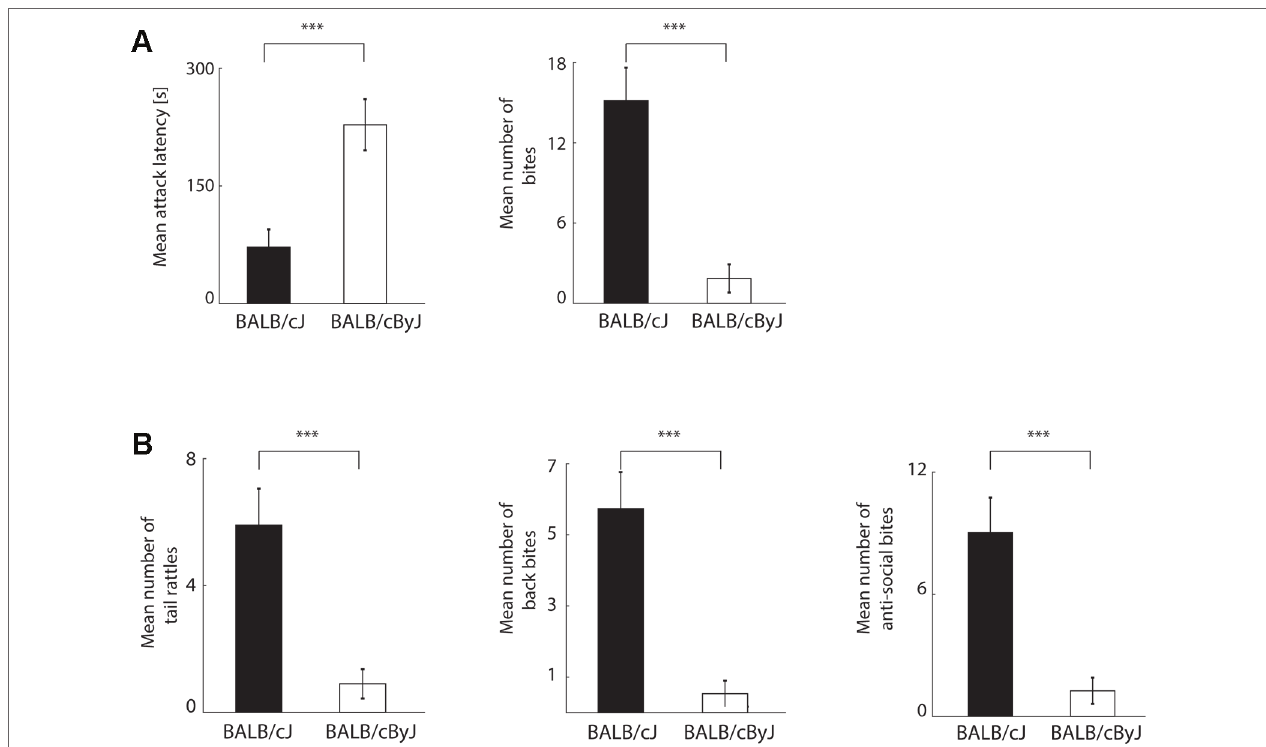
FIGUrE 1 | Behavioral read-outs of aggression (A) Left panel: average of attack latencies across first three days of resident intruder (RI) testing. Black bar: BALB/cJ mice. White bar: BALB/cByJ mice. Error bars: standard error of the mean (SEM). Right panel: same for number of bites. (B) Left and middle panel: average number of tail rattles and back bites (socially acceptable aggression) across first three days of RI testing. Black bar: BALB/cJ mice. White bar: BALB/cByJ mice. Error bars: standard error of the mean (SEM). Right panel: same for anti-social bites (sum of face, neck, and belly bites). *** p <